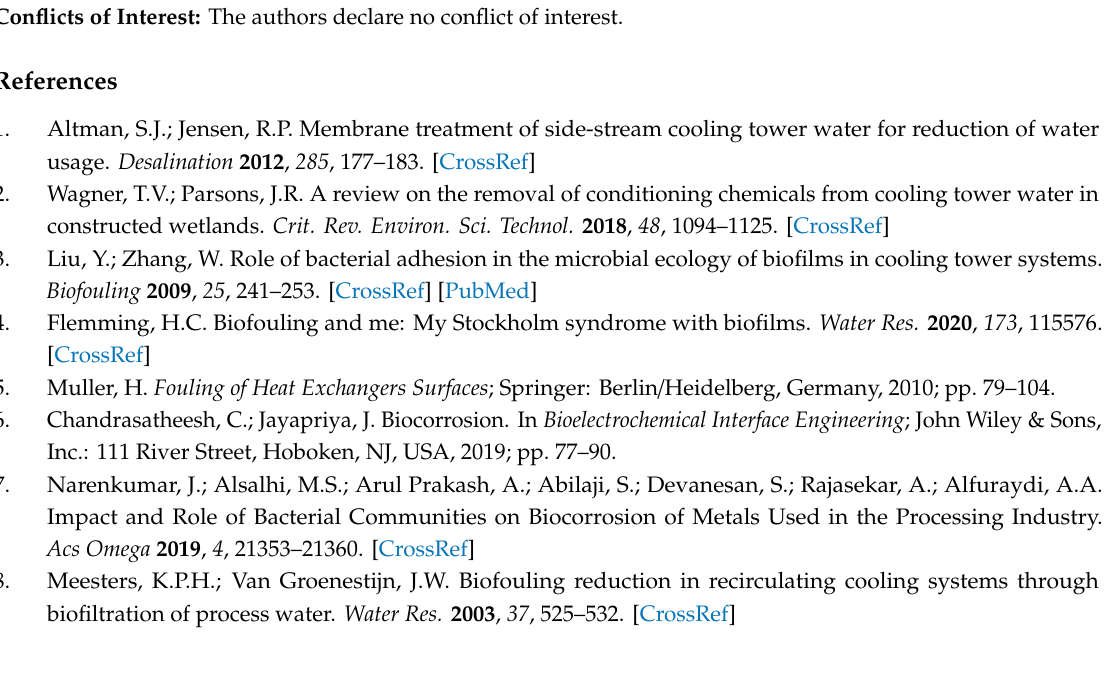
Table S1: Oxygen Respiration measurement setup, Figure S1: Flowchart visualising the respective analyses (in yellow) that were carried out for the sample